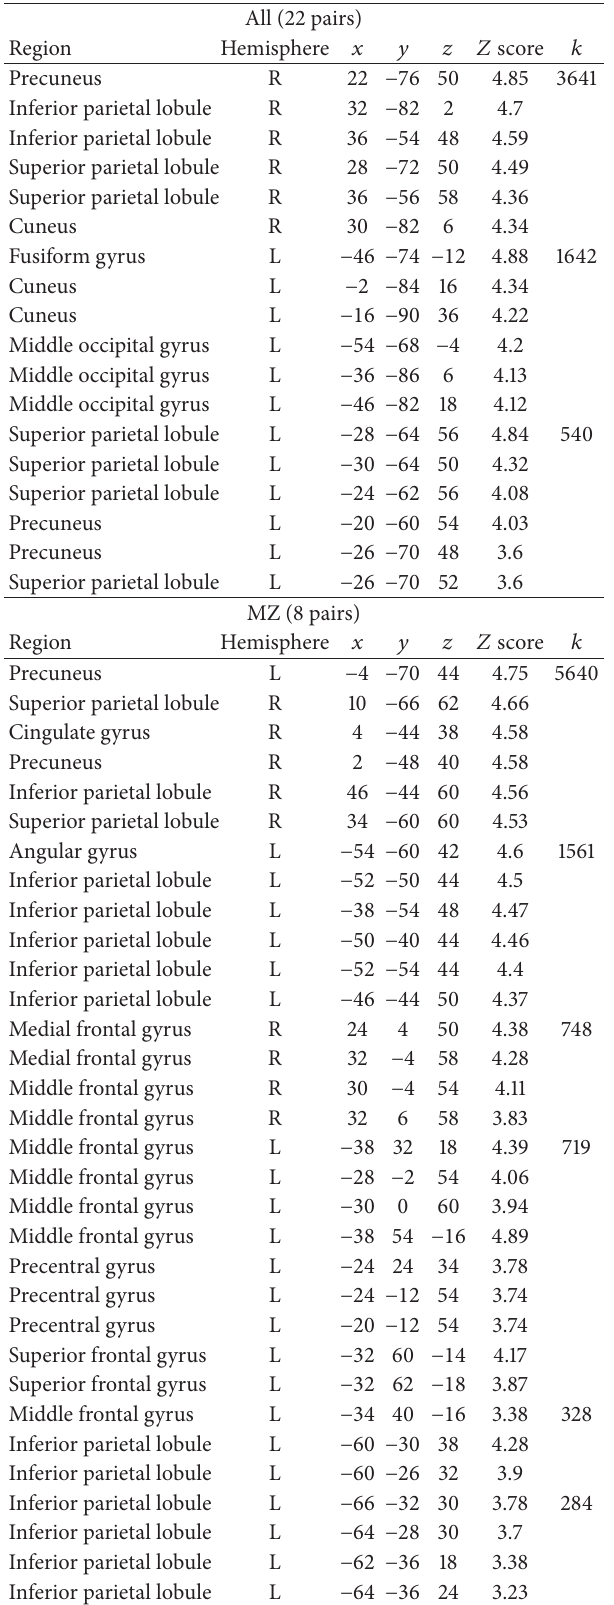
Table 4: Regions associated with increased activation in type 2